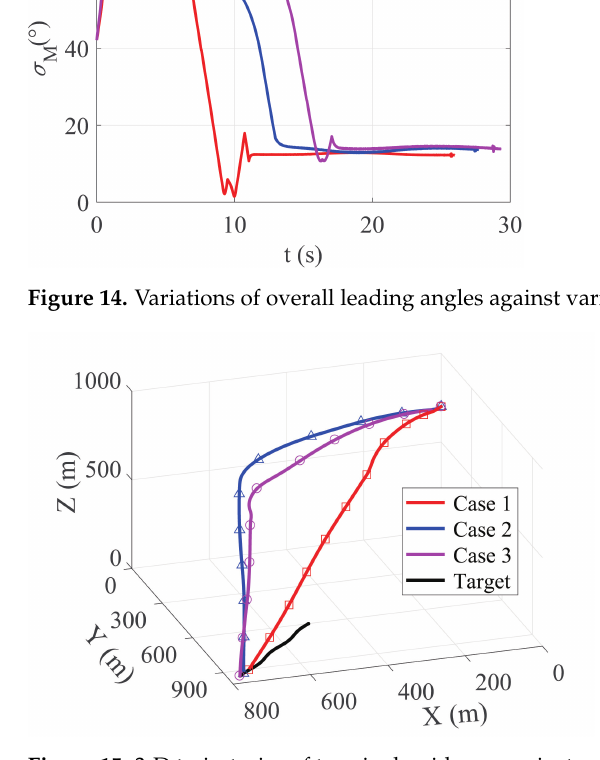
Figure 15. 3-D trajectories of terminal guidance against variable maneuvering targets. Table 2. Terminal guidance performance for attacking variable maneuvering